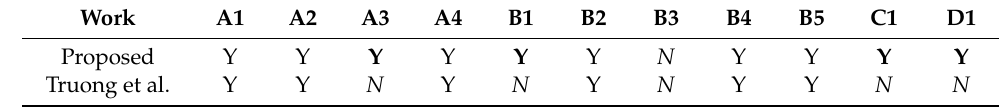
Table 7. Comparative analysis between this work and the work of Truong et